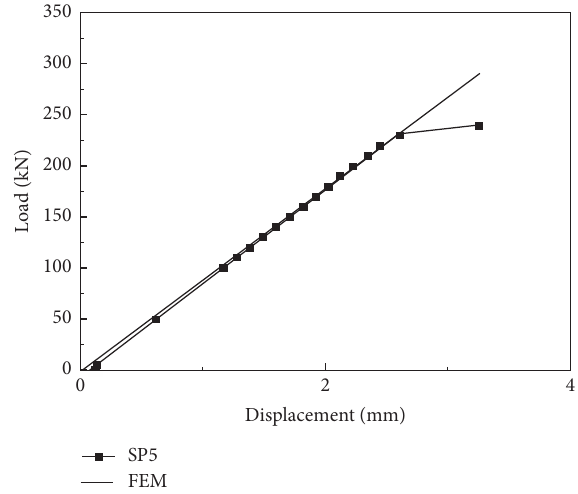
Figure 20: Comparison of load-deflection curve between simpli- fied model and test